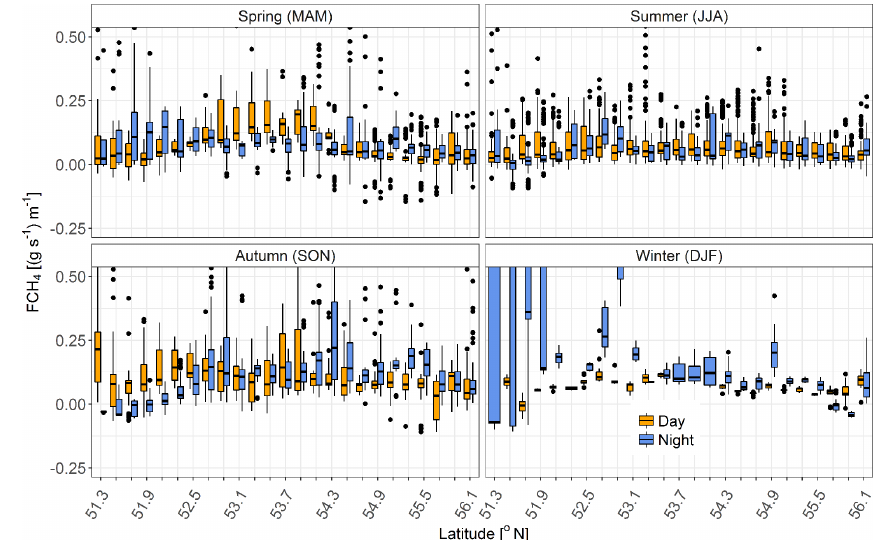
Figure 9. Box and whisker plots of 5min binned averages of CH 4 fluxes along the route of the ferry (latitude bin width: 0.2 ◦ ) segregated into day and night contributions. The horizontal bar within each box corresponds to the median for a given latitude bin, the upper and lower hinges represent the 75th and 25th quantiles, respectively, and the upper and lower whiskers indicate the largest–smallest observation less– greater than or equal to upper–lower hinge ± 1 . 5 ∗ IQR (inter-quantile range), respectively. The outliers are represented by solid circles and arithmetic means by red diamonds. The flux is integrated over the height of the planetary boundary layer and expressed in units of mass flux per metre travelled crosswind within each latitude bin per unit